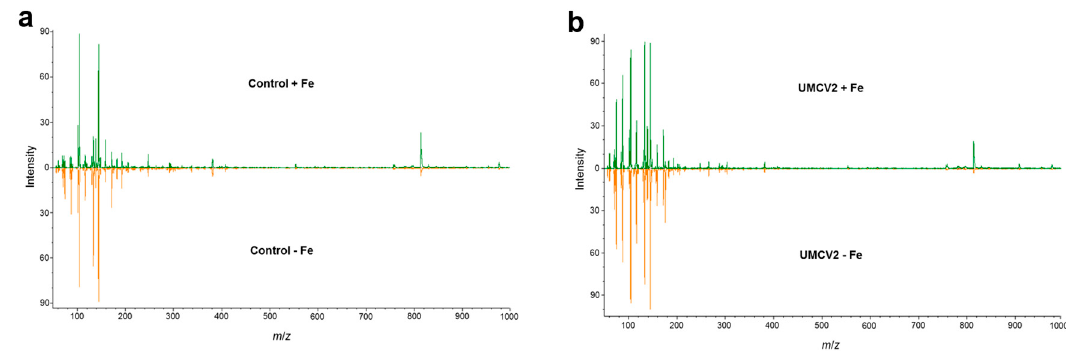
Figure 2. Non-targeted metabolomic profiling normalized from leaves of Medicago truncatula obtained by DLI-ESI-MS. ( a ) Control plants grown under Fe-sufficient (green) and -deficient conditions (orange). ( b ) Plants exposed to volatile compounds from A. agilis UMCV2 for 10 days and grown under iron-sufficient (green) and -deficient conditions (orange).